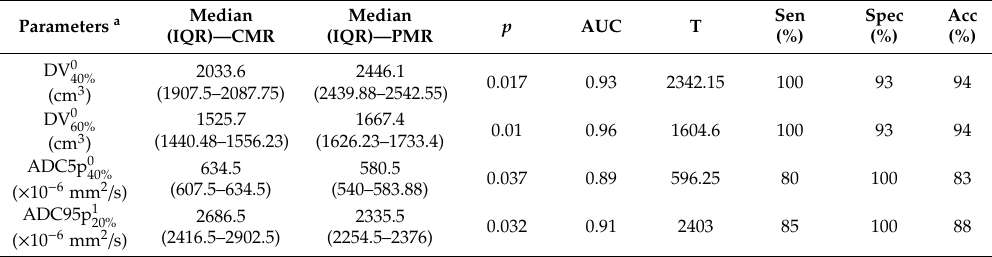
Table 4. Significant results for prediction of end-of-treatment response.